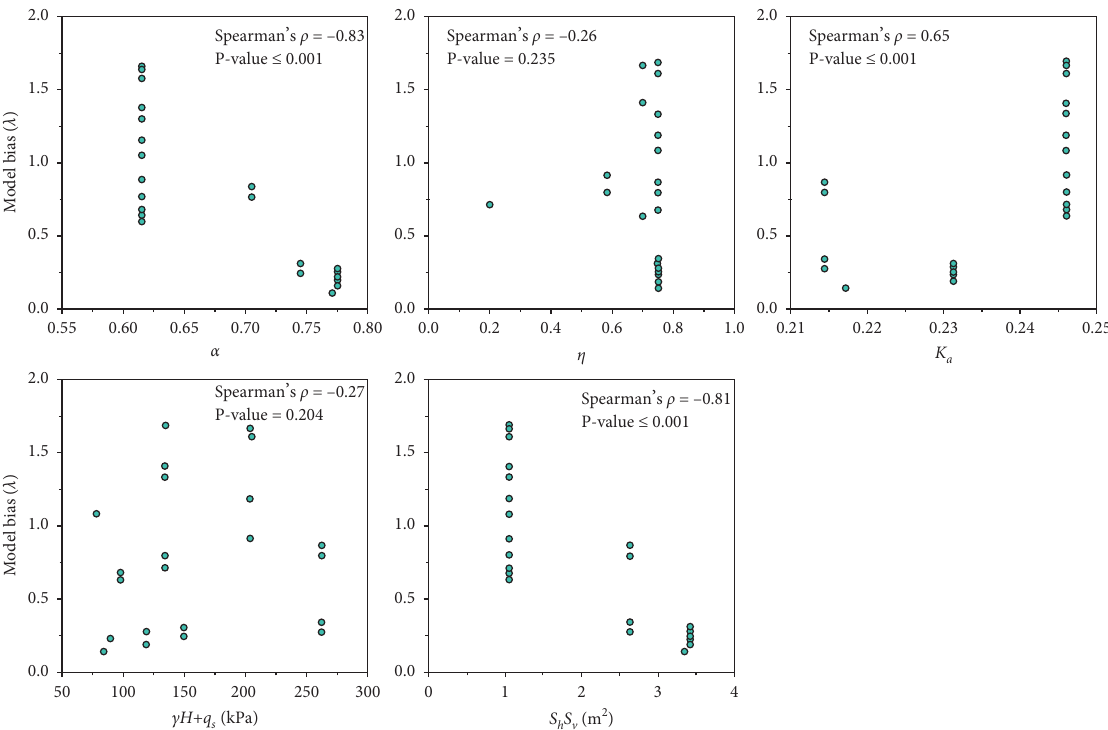
Figure 3: Plots of model bias λ for the default FHWA facing load model against various input